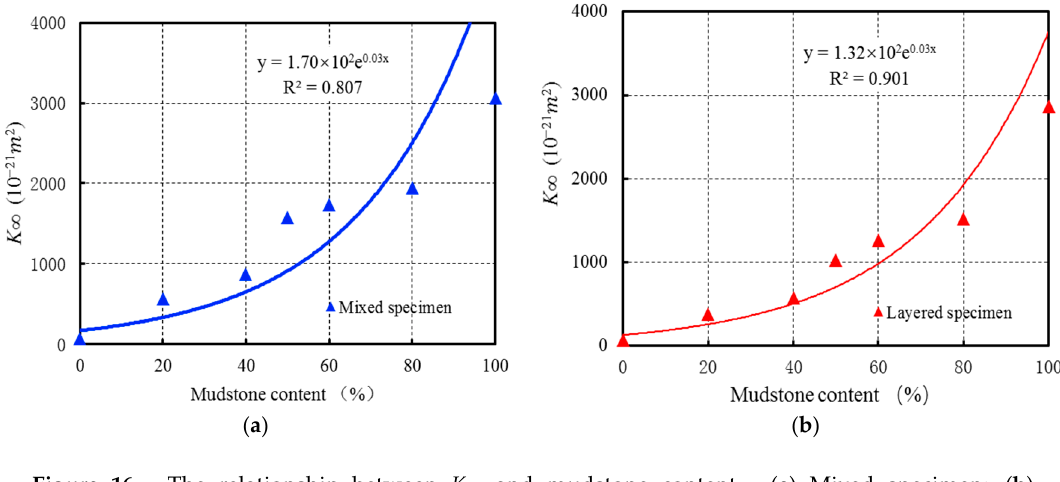
Figure 16. The relationship between K ∞ and mudstone content. ( a ) Mixed specimen; The relationship between K ∞ and mudstone content. ( a ) Mixed specimen; ( b ) layered ( b ) layered specimen.